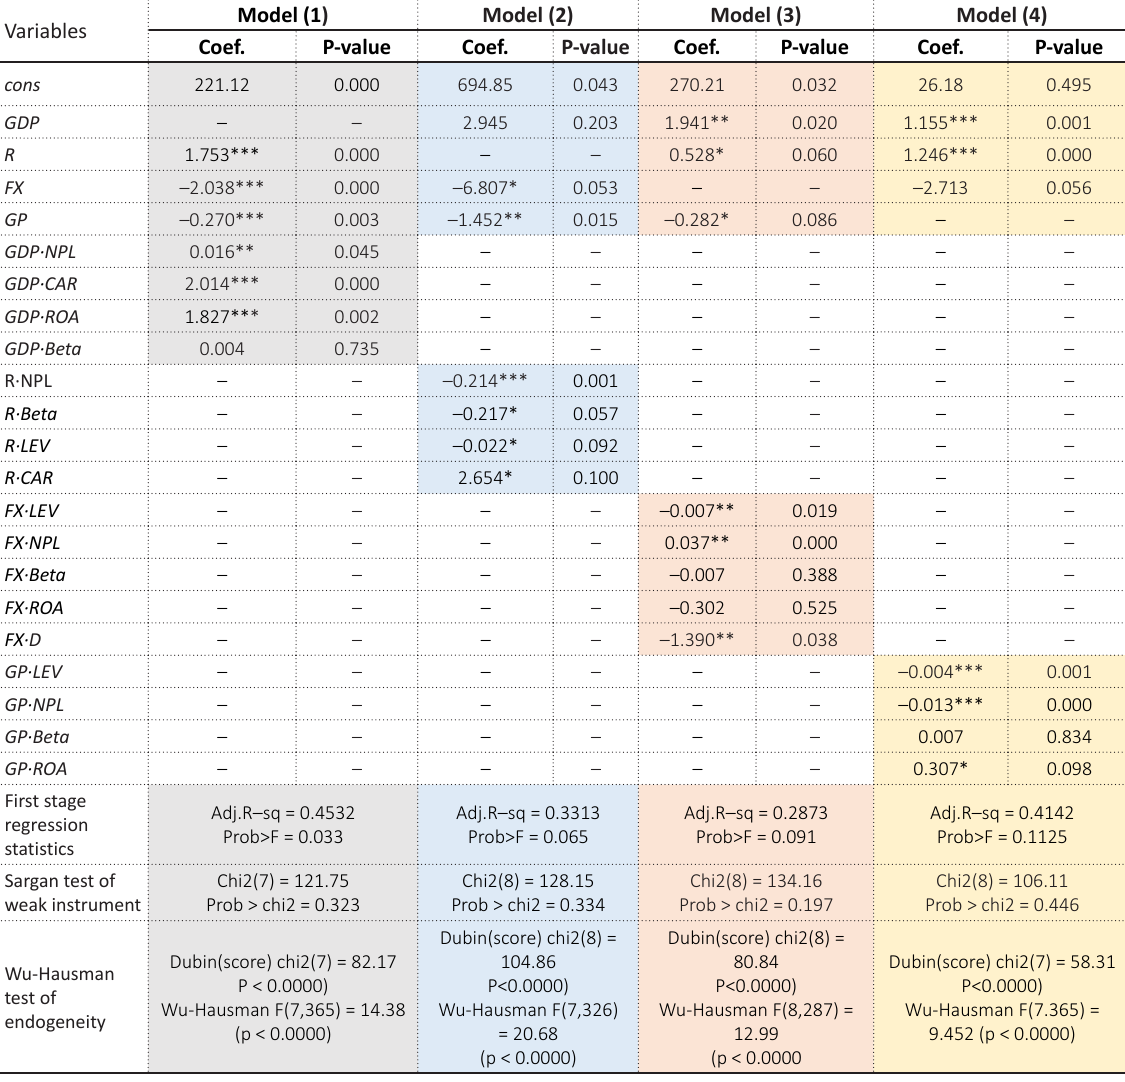
Table 4. Effects of macroeconomics and bank performance on bank share prices